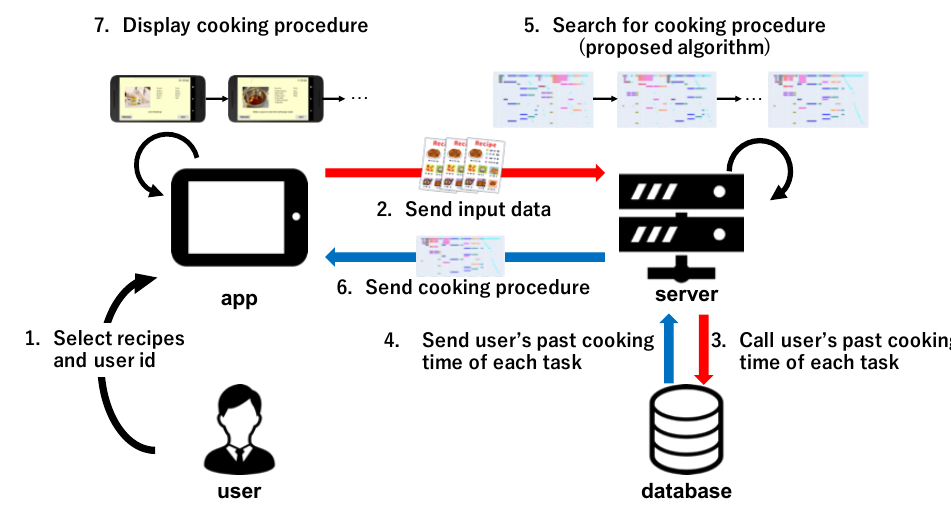
Figure 2. Structure and data flow of our proposed